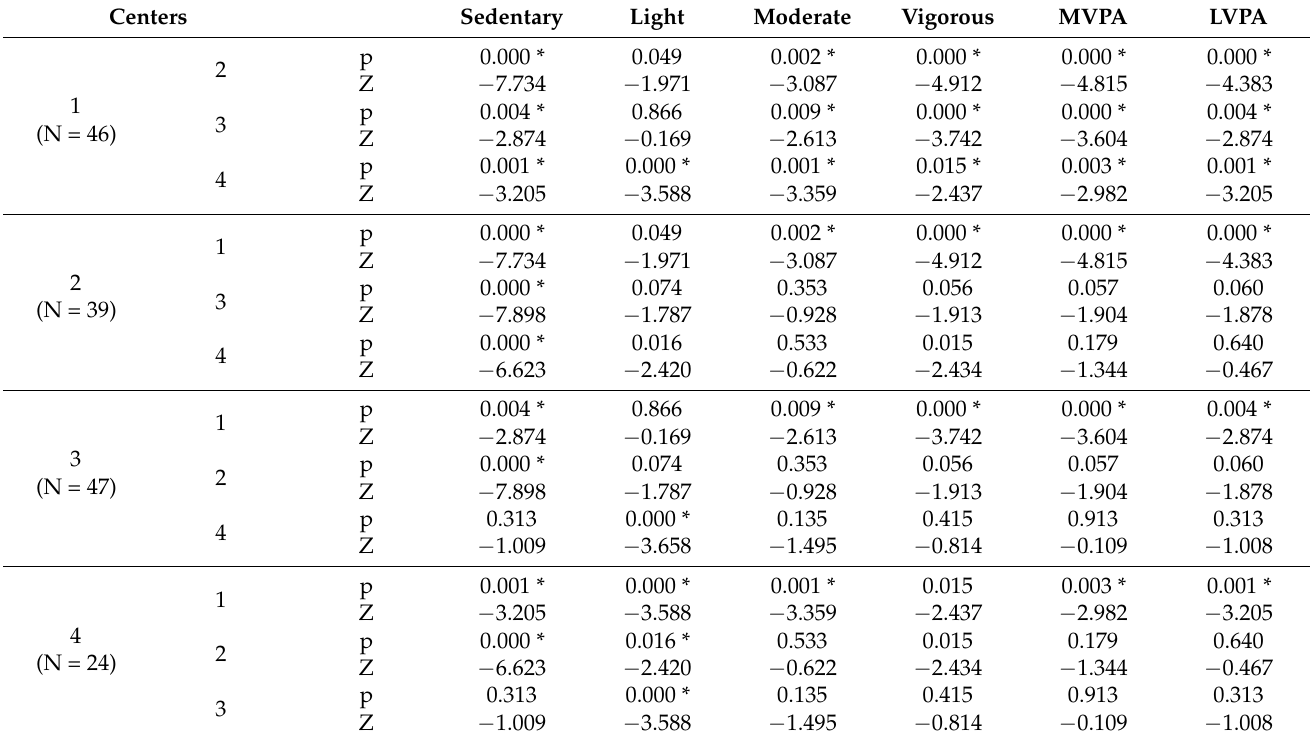
Table 2. Differences found between PA performed and the different intensities among centers.